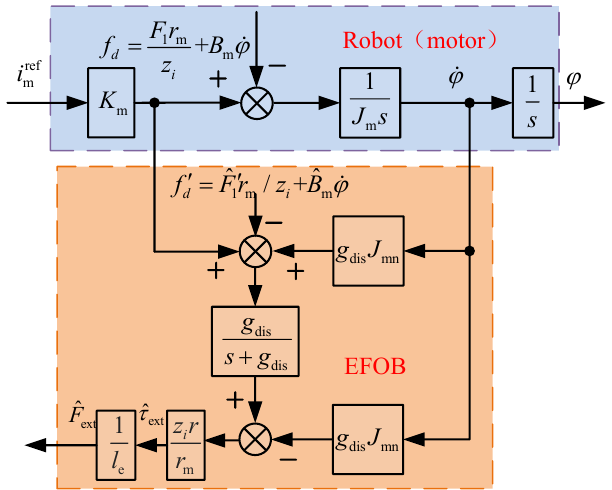
Figure 6. The external force estimator for the single joint system model based on DOB.